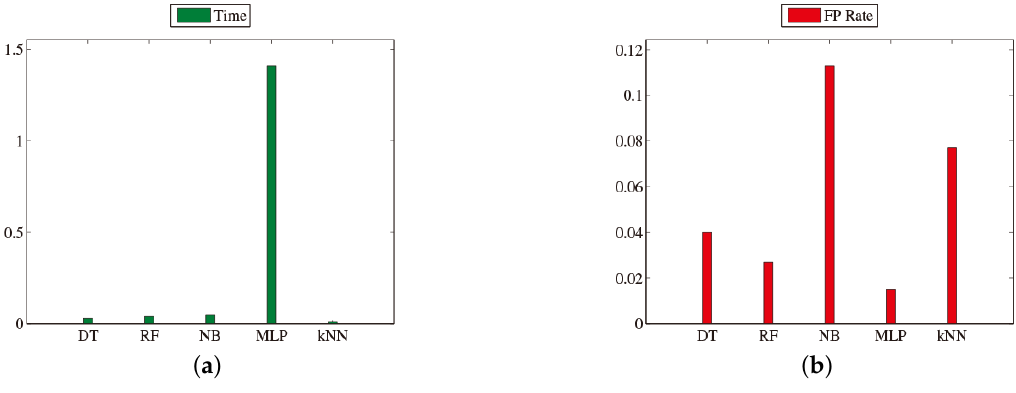
Figure 7. ( a ) Total time and ( b ) FPR of different